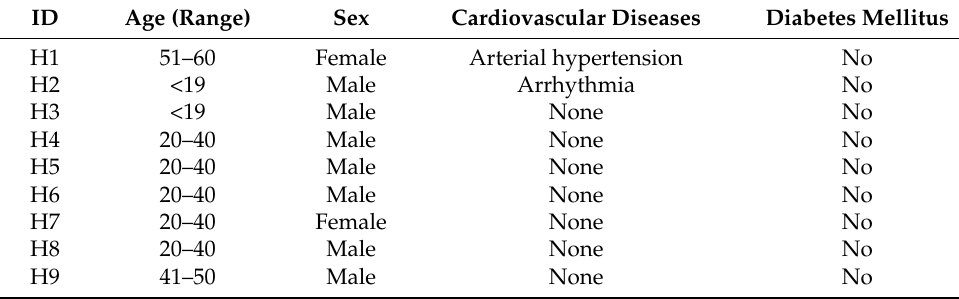
Table 1. Demographic and clinical characteristics of healthy controls.